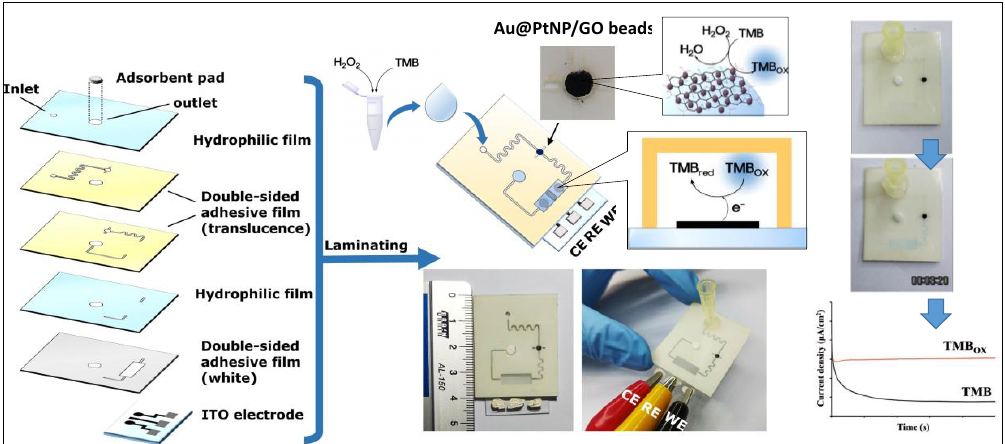
Figure 8. The fabrication procedure of microfluidic paper-based device and further electrochemical detection of H 2 O 2 based on its reduction on Au@PtNP/GO nanozymes to oxidize 3,3′,5,5′- tetramethylbenzidine (TMB) in 1 min. The oxidized TMB was subsequently migrated to the working electrode for being reduced on ITO substrate and further detected using amperometric technique. Reproduced with permission from [119]. Table 3. Reported literature for graphene-based chemosensors for electrochemical detection of NO and H 2 O 2 .